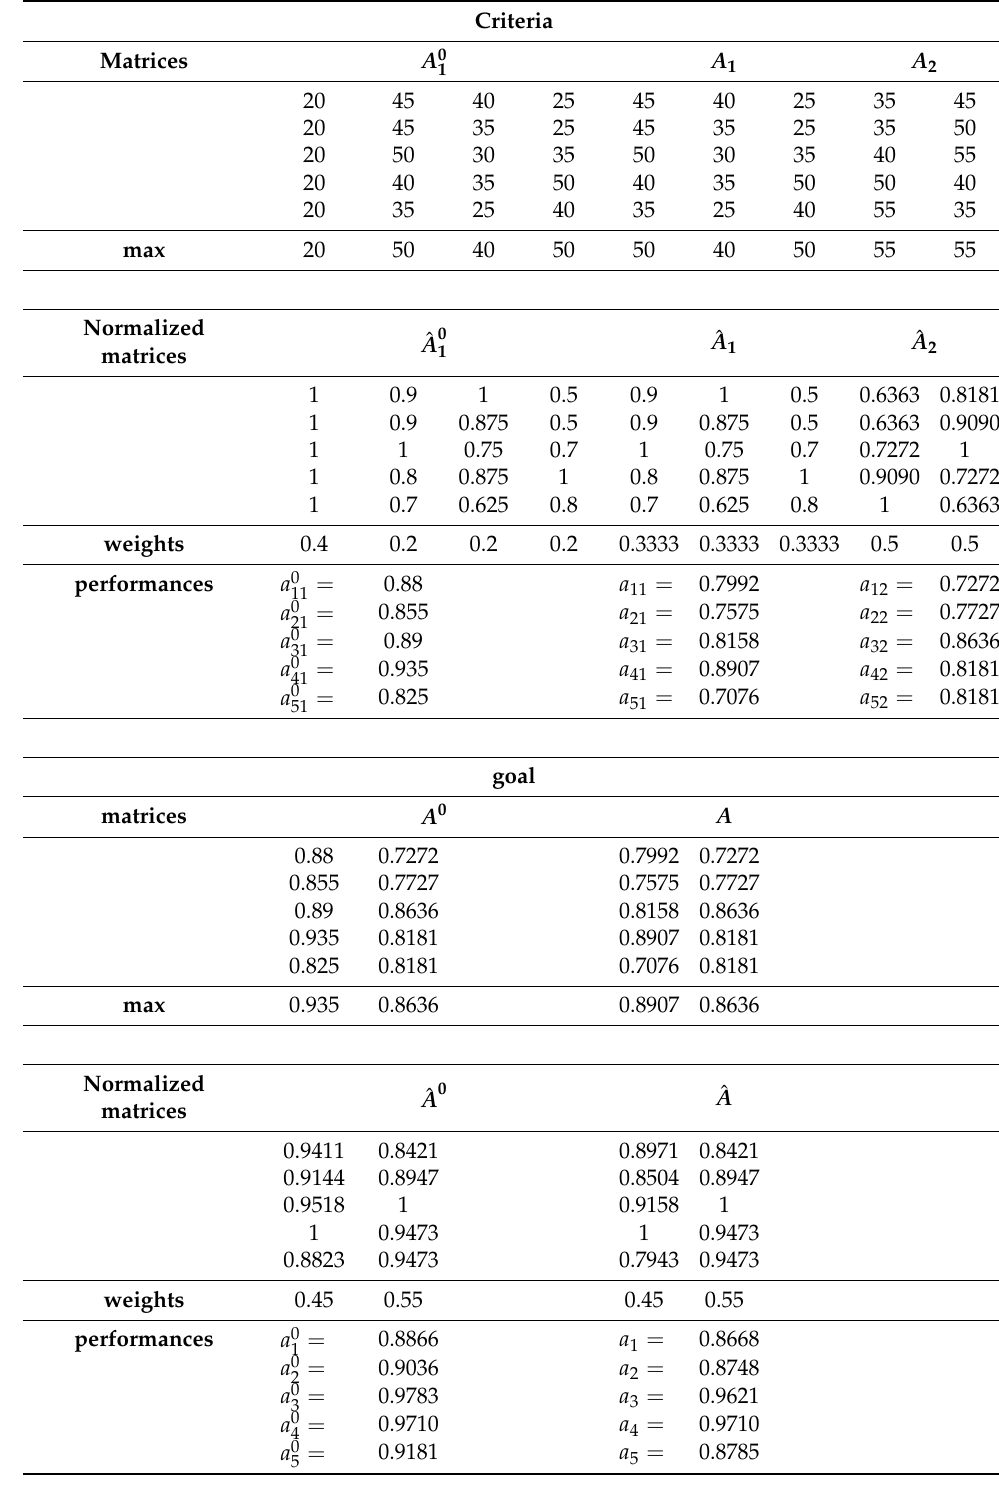
Table A1. Summary of Example 1 solution with SAW